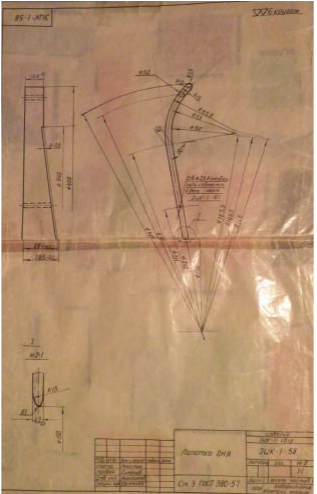
Figure 3: Geometry of the